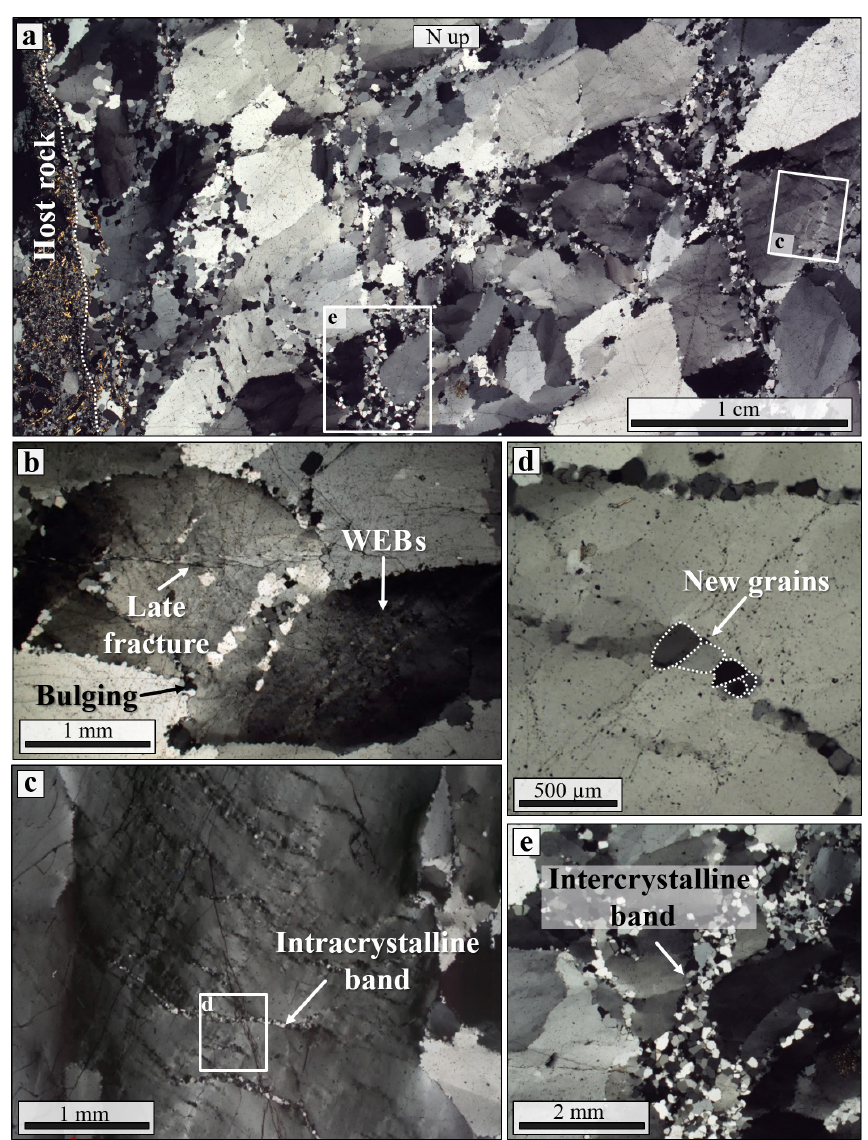
Figure 6. Microtextural characteristics of Qtz I from the BFZ300 core (sample TPH-120-4). (a) Stitched photomicrographs showing the typical heterogeneous grain size of Qtz I (30–800µm). (b) Evidence of plastic deformation of Qtz I from the fault core given by bulging of the largest crystals, wide extinction bands, and undulose extinction. Note the late brittle fractures cross-cutting all the previously formed plastic features. (c) Intracrystalline deformation bands within a large crystal. (d) Detail of (c) showing the typical grain size of the band (50– 250µm). Intracrystalline deformation bands are oriented at <30 ◦ with respect to the BFZ300 vein walls and can be up to 2mm in length. (e) Intercrystalline deformation band showing a thickening at the triple junction of larger grains. These intercrystalline bands are parallel to the strike of